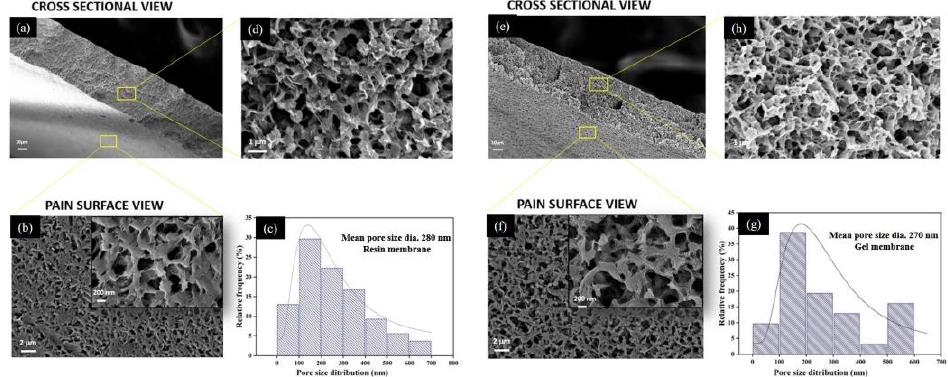
Figure 7. SEM micrograph at different magnifications for resin membrane (( a ) cross-section at low magnification, ( b ) plain surface, ( c ) statistical data of pore size distribution and ( d ) cross-section from top to bottom at high magnification) and gel membrane (( e ) cross-section at low magnification, ( f ) plain surface, ( g ) statistical data of pore size distribution and ( h ) cross-section from top to bottom at high magnification). Table 3. Membrane properties and performance analysis.